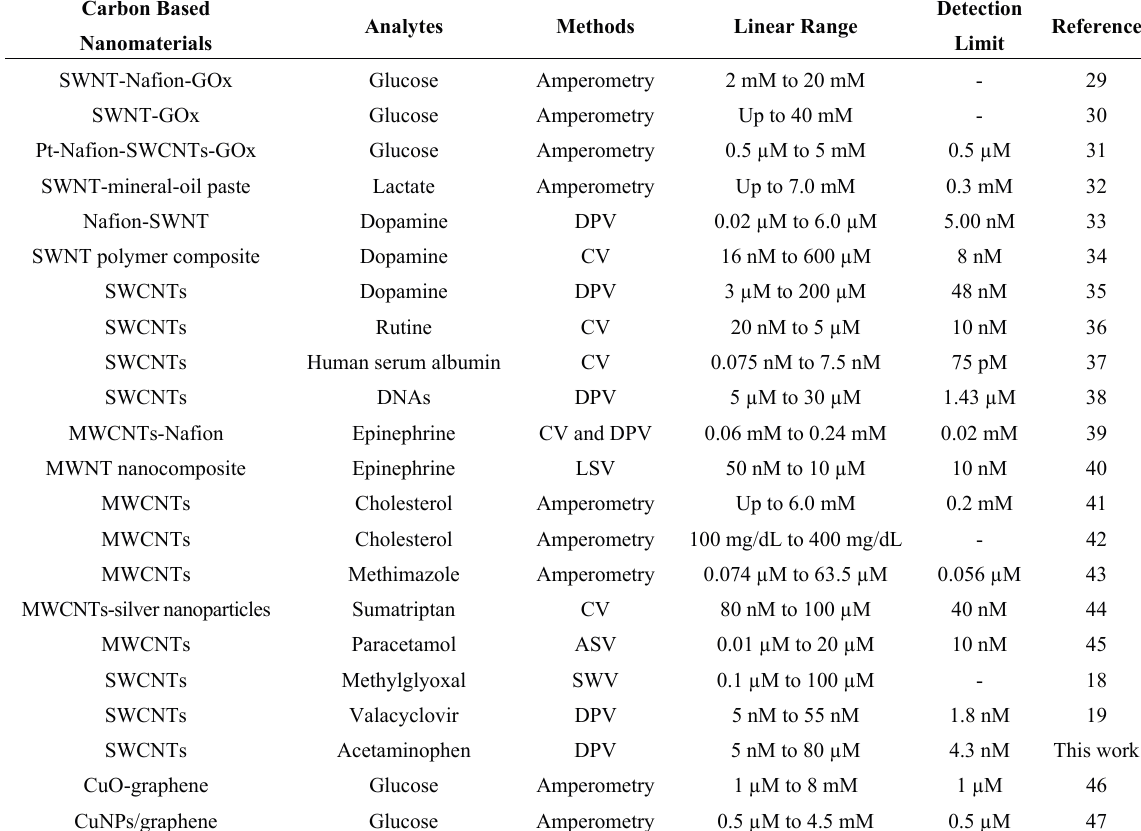
Table 1. List of electrochemical sensors and biosensors based on carbon nanomaterials and their composites for the detection of biological and pharmaceutical